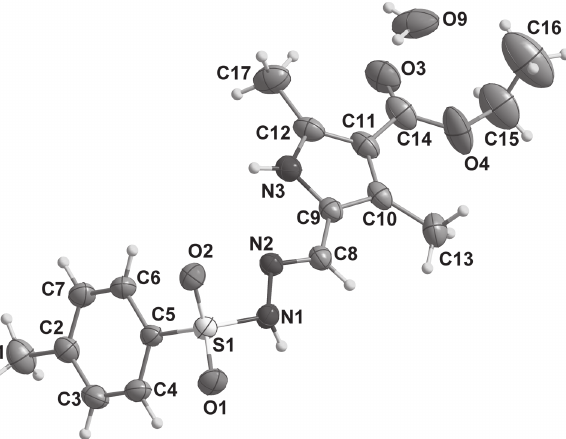
Table 1: Data collection and